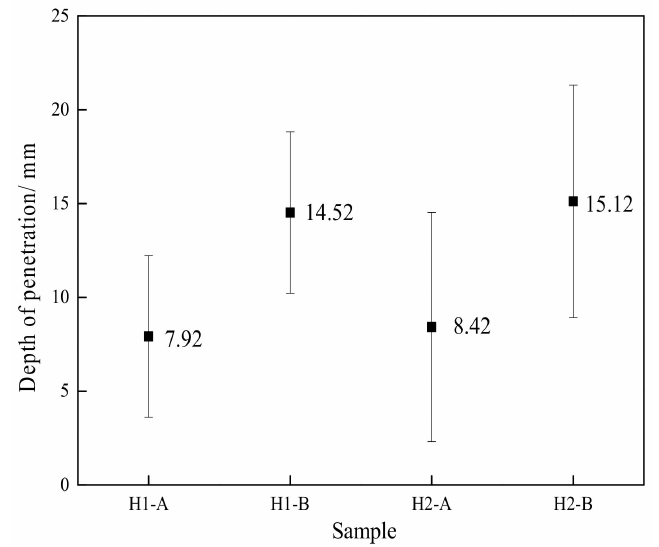
Figure 8. Penetration among slag–iron–coke under different charging